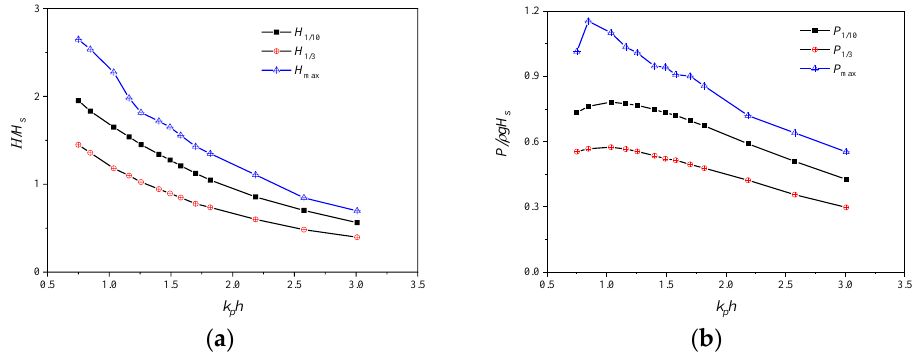
Figure 8. Comparison of different characteristic values of ( a ) wave heights at chamber center and ( b ) pneumatic pressures in the chamber versus k p h .